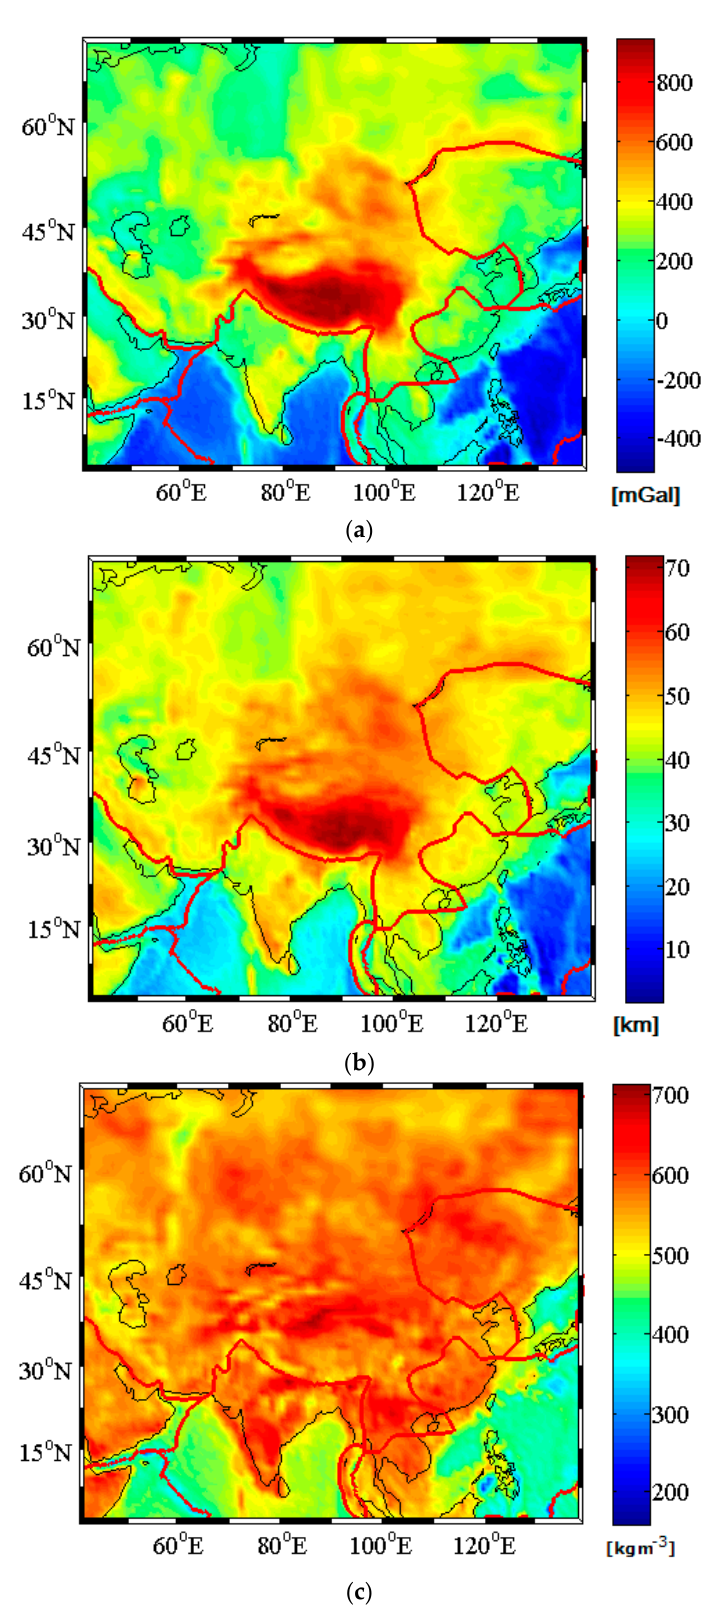
Figure 6. Effect of the consolidated crust-stripping gravity correction to Moho parameters: ( a ) the combined gravitational contribution of topography, bathymetry, sediments and consolidated crust. The estimated values of: ( b ) Moho depth and ( c ) Moho density contrast.